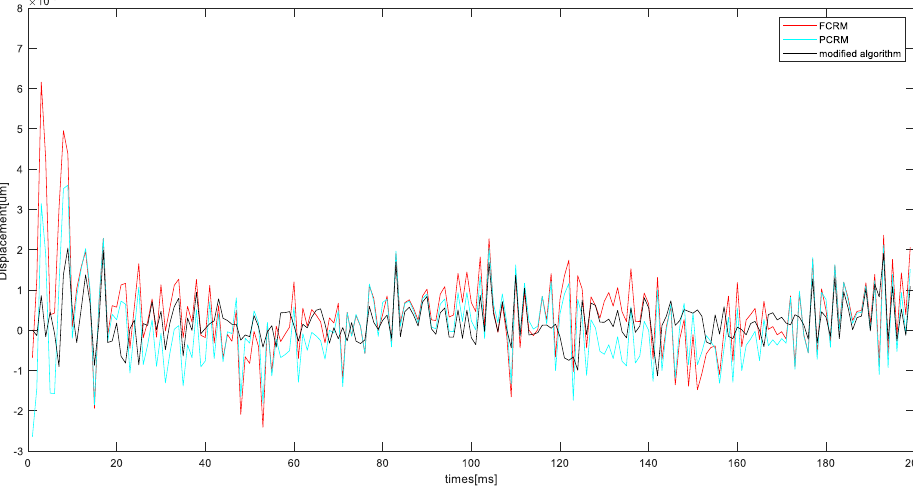
Figure 12. Error comparison of the modified model, FCRM, and PCRM when the frequency is 40 Hz.